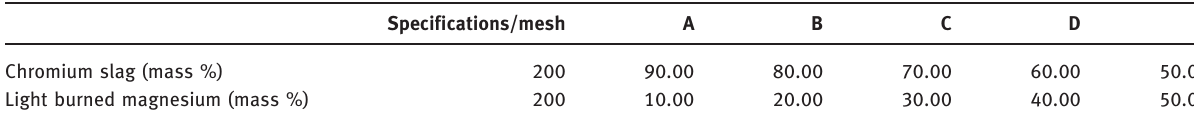
Table 4: Size and proportion of the two materials used in the experiment.